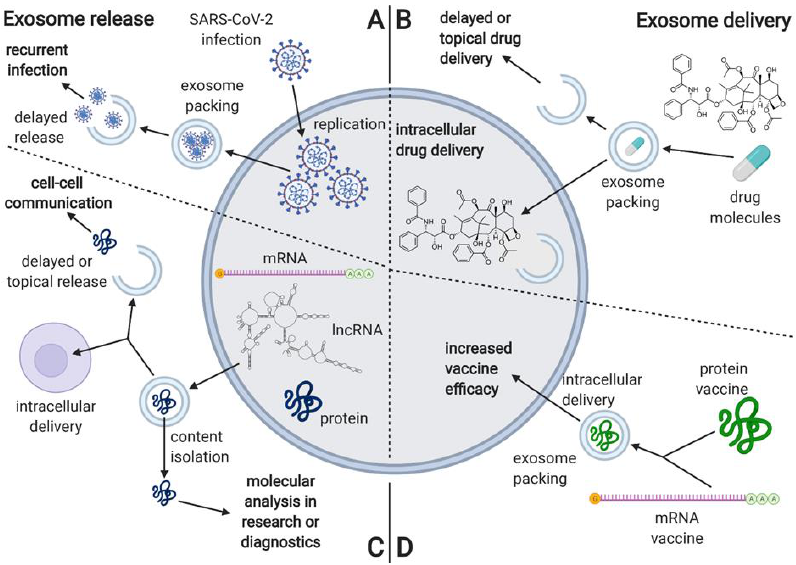
Figure 5. The characterization of processes associated with exosome release, including the proposed mechanism of delayed viral re-infection, as well as the proposed applications associated with exosome delivery. ( A ) he proposed mechanism of exosome involvement in SARS-CoV-2 reinfection; ( B ) overview of the proposed applications including exosome delivery; ( C ) the usual mechanisms and applications of exosome release; ( D ) overview of the potential applications of exosomes in vaccine delivery. Created with